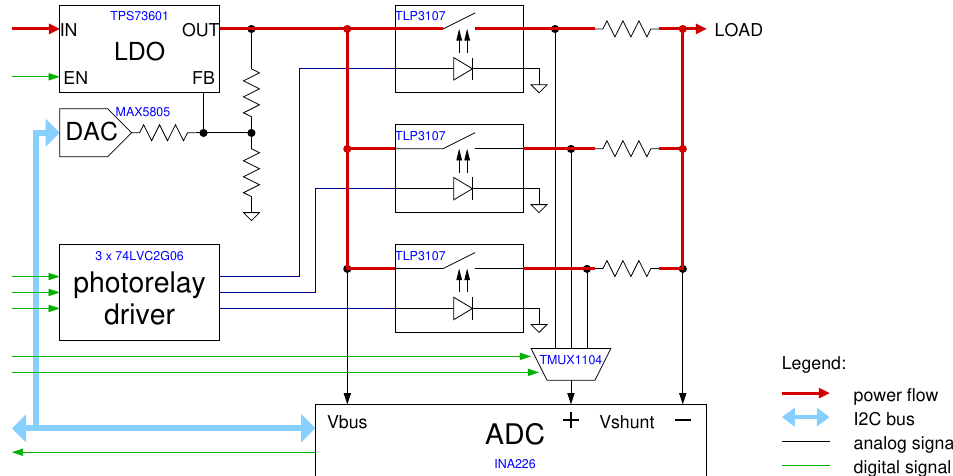
Figure 7. Block diagram of the custom-made source-meter unit. The photorelay driver contains pulse-shaping circuitry to drive the relays with minimum turn-on and turn-off times, allowing make- before-break operation while switching from one sensing resistor to another. The DAC-controlled LDO allows selection of output voltage from 1V to 5V in 1mV increments. The whole system is software controlled by a Raspberry Pi (not shown) that drives the digital signals that control the photorelays and the multiplexers through some GPIO pins, plus acquire the data through its I2C bus. Current measurement can be performed at up to a 3 kHz sampling frequency, and sam- pling times are accurately timestamped at microsecond resolution against absolute time as recorded by a clock servoed to a local time server, so that current measurements can be accurately related to BLE events as recorded from the receiving PC, as shown in